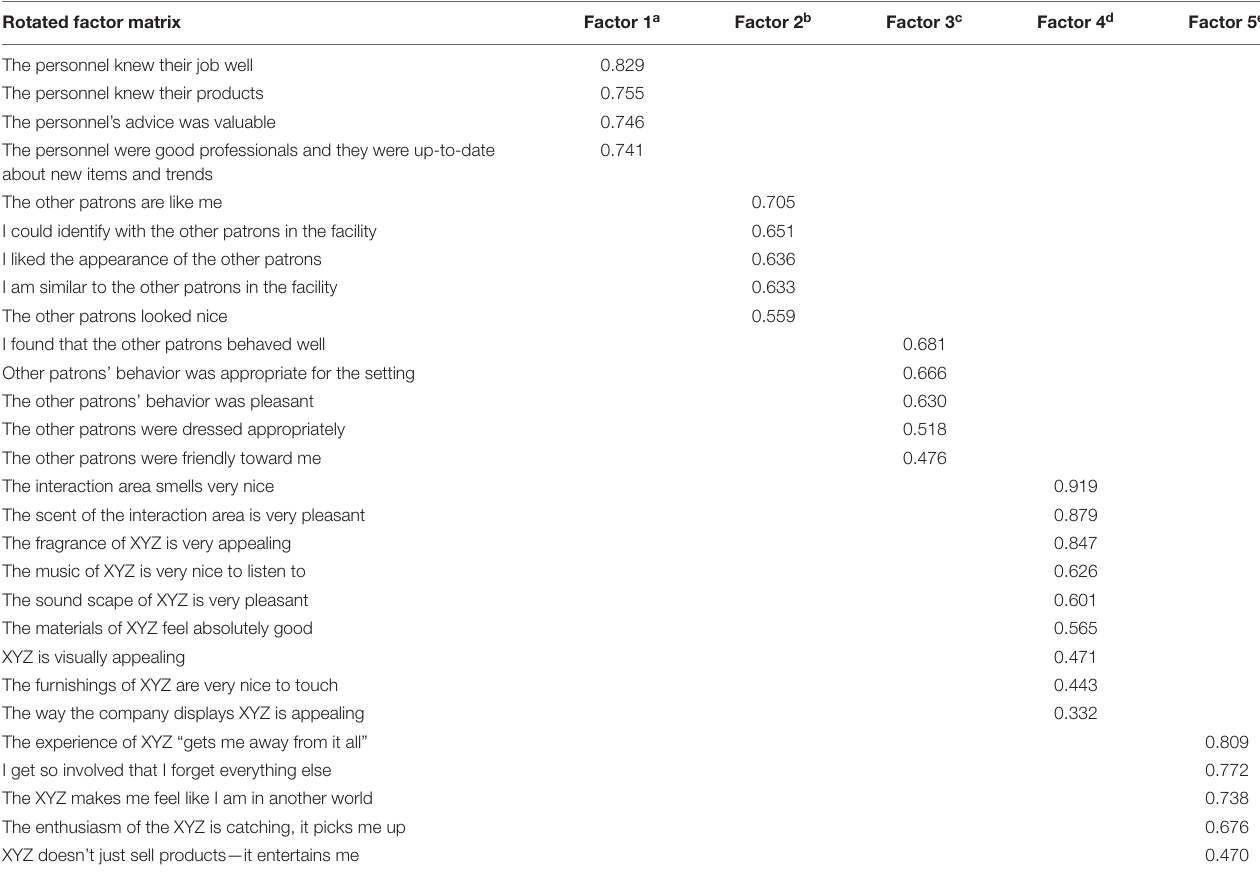
TABLE 3 | Results of principal axis factoring.